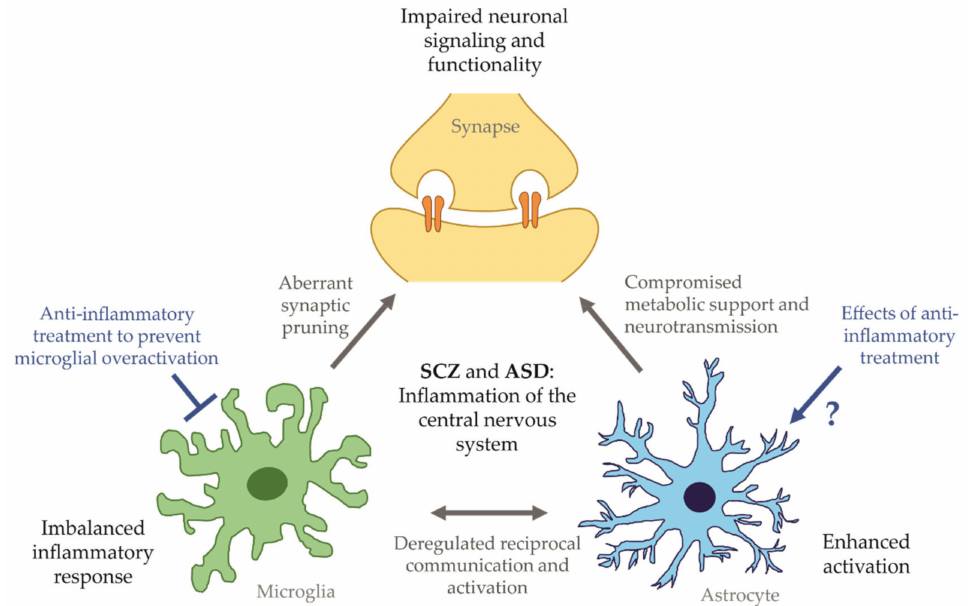
Figure 3. Impaired communication of glia cells and neurons as a consequence of CNS inflammation. The imbalanced reciprocal activation of microglia and astrocytes may lead to the development of neuronal pathologies, contributing to the onset and progression of neuropsychiatric disorders like SCZ and